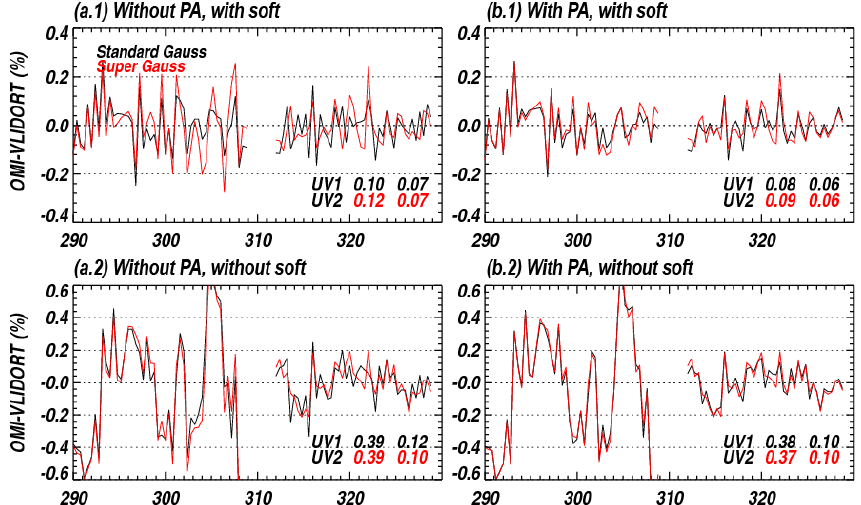
Figure 8. Average differences (%) between measured (OMI) and simulated (VLIDORT) radiances at the nadir cross-track pixel in the tropics (30–30 ◦ S) from measurements used in Fig. 4, without (a) and with (b) zero-order pseudo absorbers (PA) when the standard Gaussian (black line) and the super Gaussian (red line) are assumed as ISRFs, respectively. Upper/lower panels represent the fitting results with soft calibration turned on/off. The residuals in the UV1 (<310nm) are scaled by a factor of 2 to fit on the given y axis. In the legend, the rms of residuals (%) is given for UV1 and UV2 wavelength